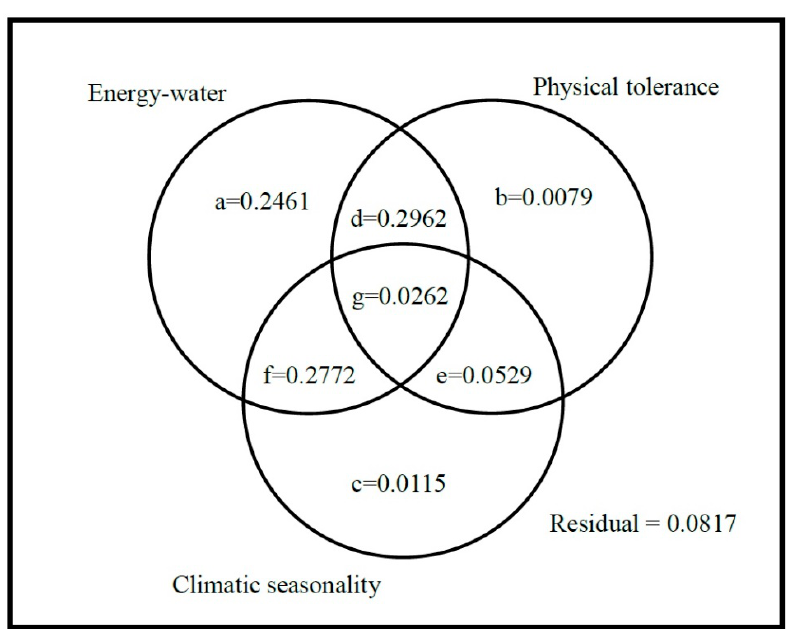
Figure 3. Results of variation partitioning between species richness and predictor sets. Each letter in the Venn diagram represents a fraction of variation partitioning analysis (the letter representing the fractions are mentioned in Section 4.4).